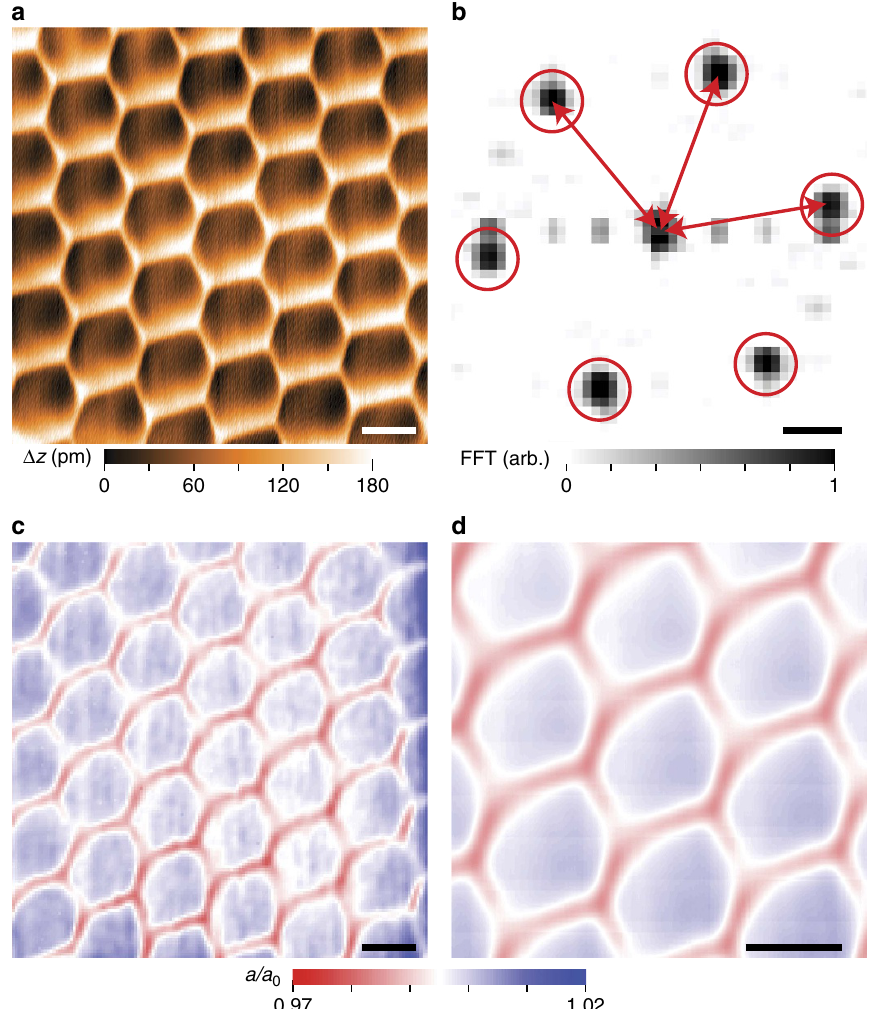
Figure 3 | Method for generating strain maps. ( a ) Atomically-resolved topography of nearly-aligned graphene on hBN. The topography was acquired with a sample voltage of V s ¼ 0.3V and a tunnelling current of I t ¼ 200pA. ( b ) Fourier transform of a 4 (cid:3) 4nm 2 region of ( a ), showing six resonances representing the hexagonal graphene lattice (red circles). The red arrows depict the measurement of the lattice constant in each direction. ( c ) Plot of the average length of the three lattice directions, as measured in ( b ) for each point in the topographic map. The points are normalized by the equilibrium graphene lattice constant a 0 . ( d ) Spatially-averaged strain map, generated by averaging ( c ) over a few moire´ unit cells. The scale bars are 10nm for ( a , c , d ) and 10nm (cid:2) 1 for ( b